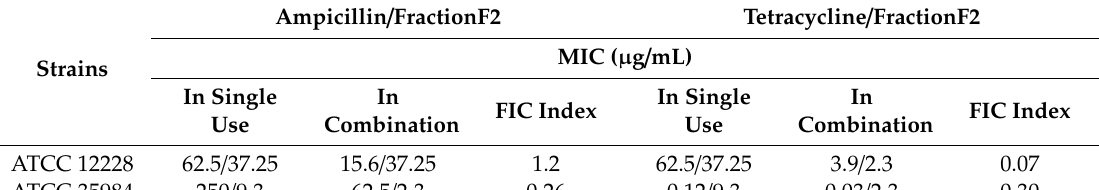
Table 3. MICs and FIC indexes of fraction F2 with antibiotics against S. epidermidis standard strains.